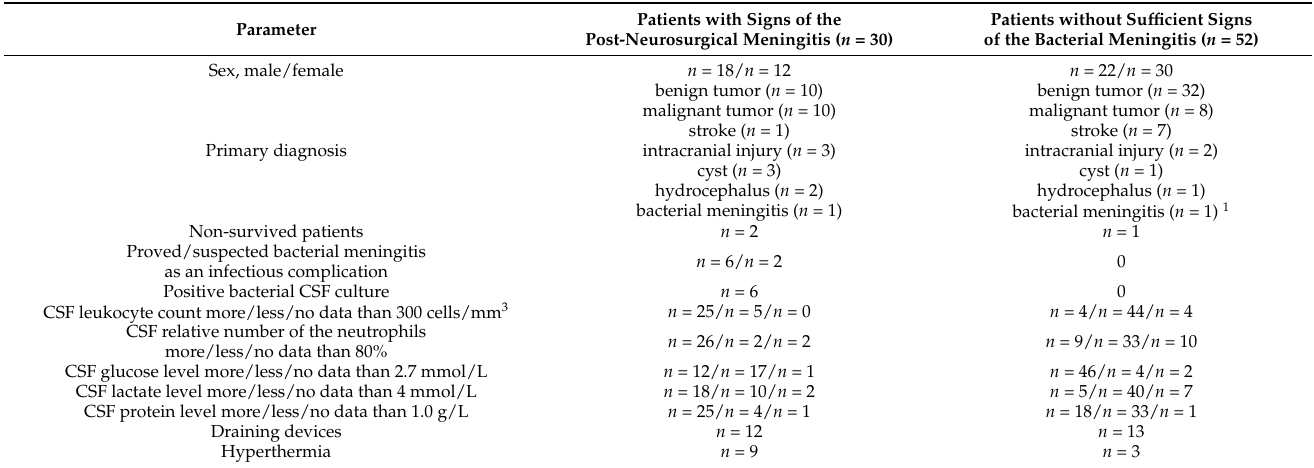
Table 1. Characteristics of the patients with and without signs of post-neurosurgical meningitis.